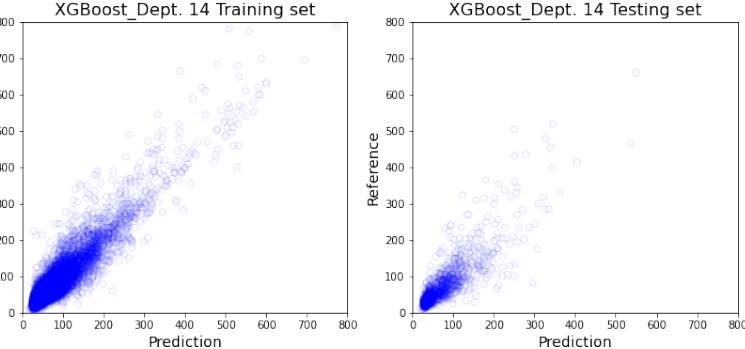
Figure A14. Model Performance of XGBoost on Dept.14. The visualization of training and testing data for department specific model on department 14 with XGBoost.